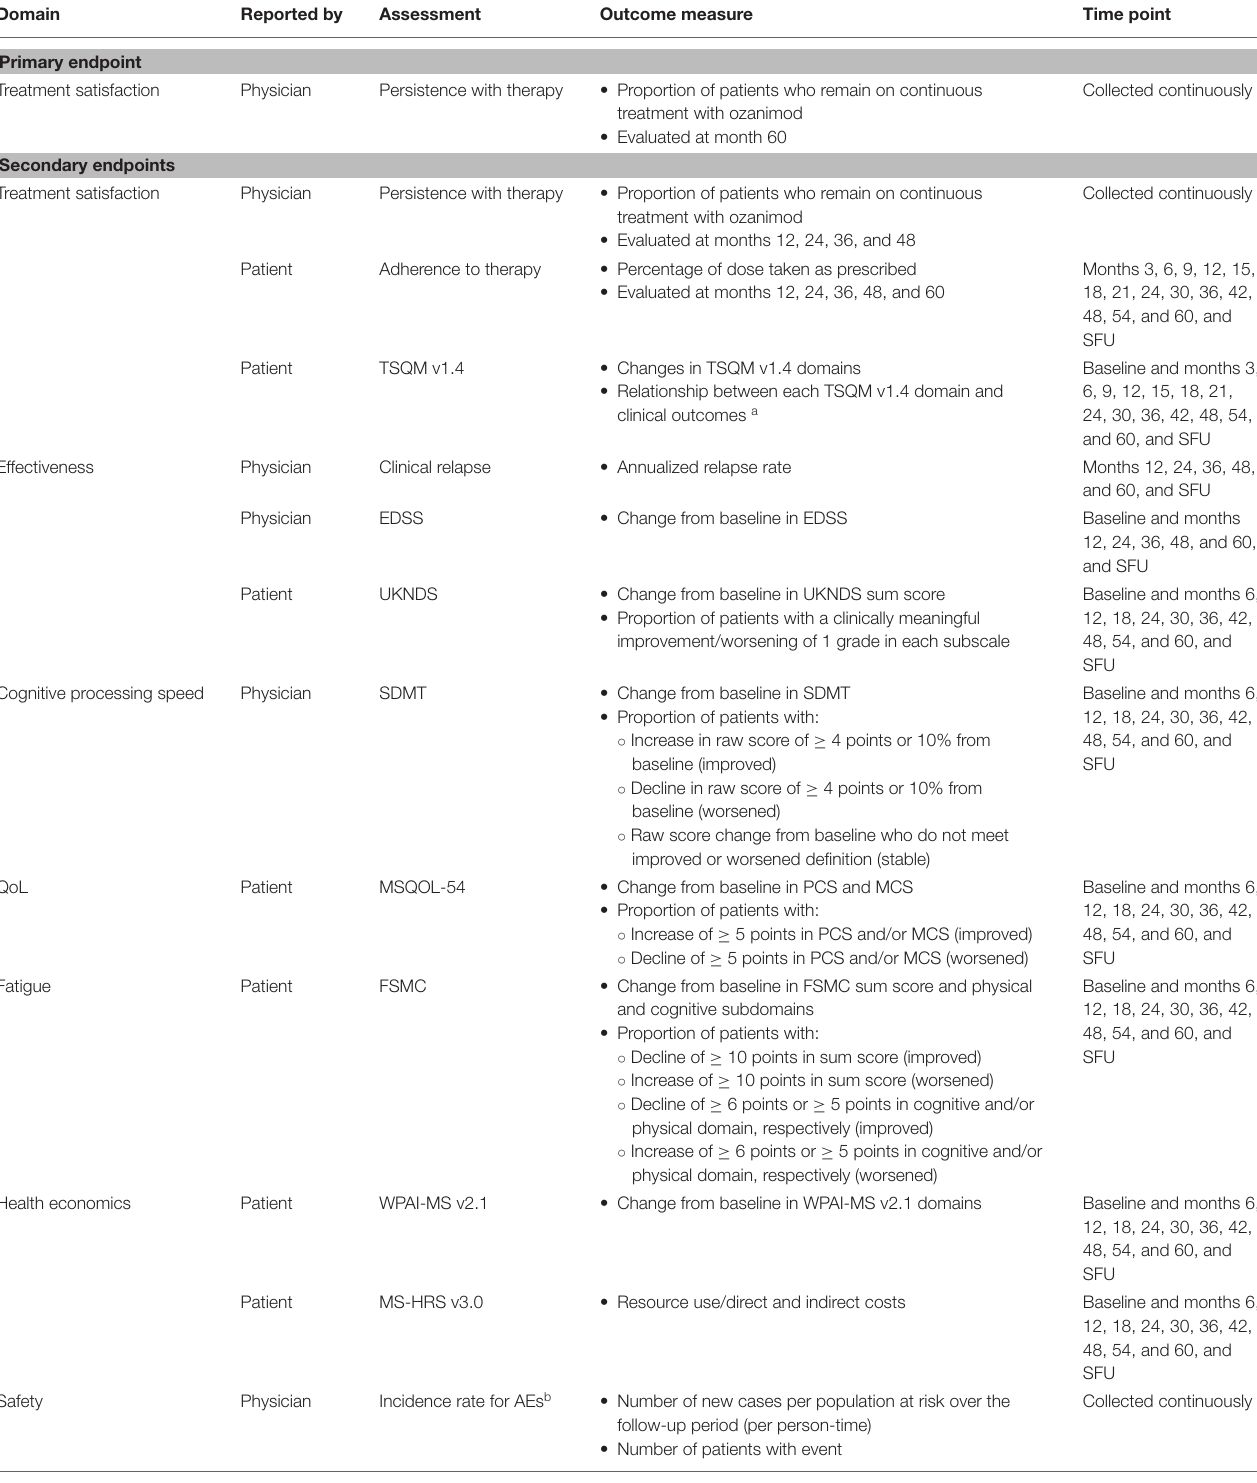
TABLE 3 | Primary and secondary endpoints in the OzEAN